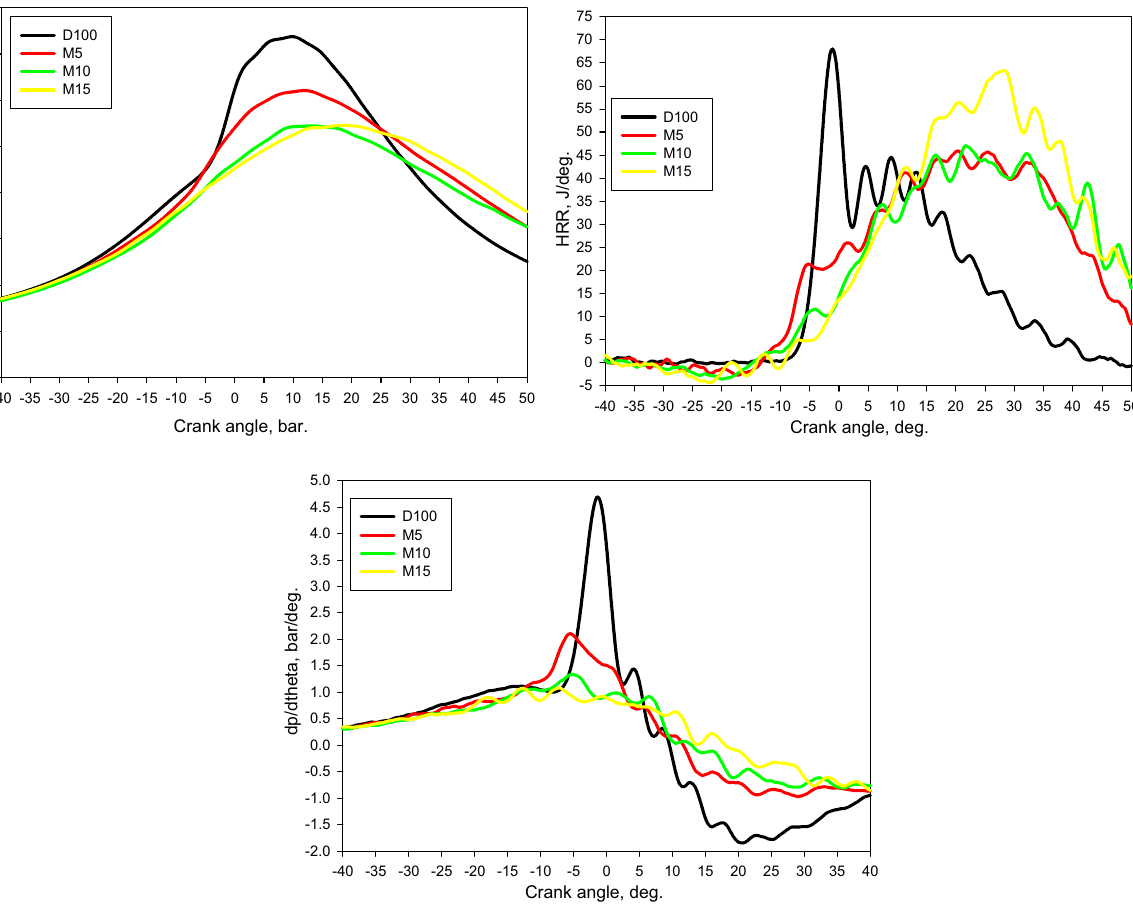
Figure 5. Discrepancy of P cyl. , HRR, and dp/dtheta via crank angle for tested fuels at bmep of 4.5